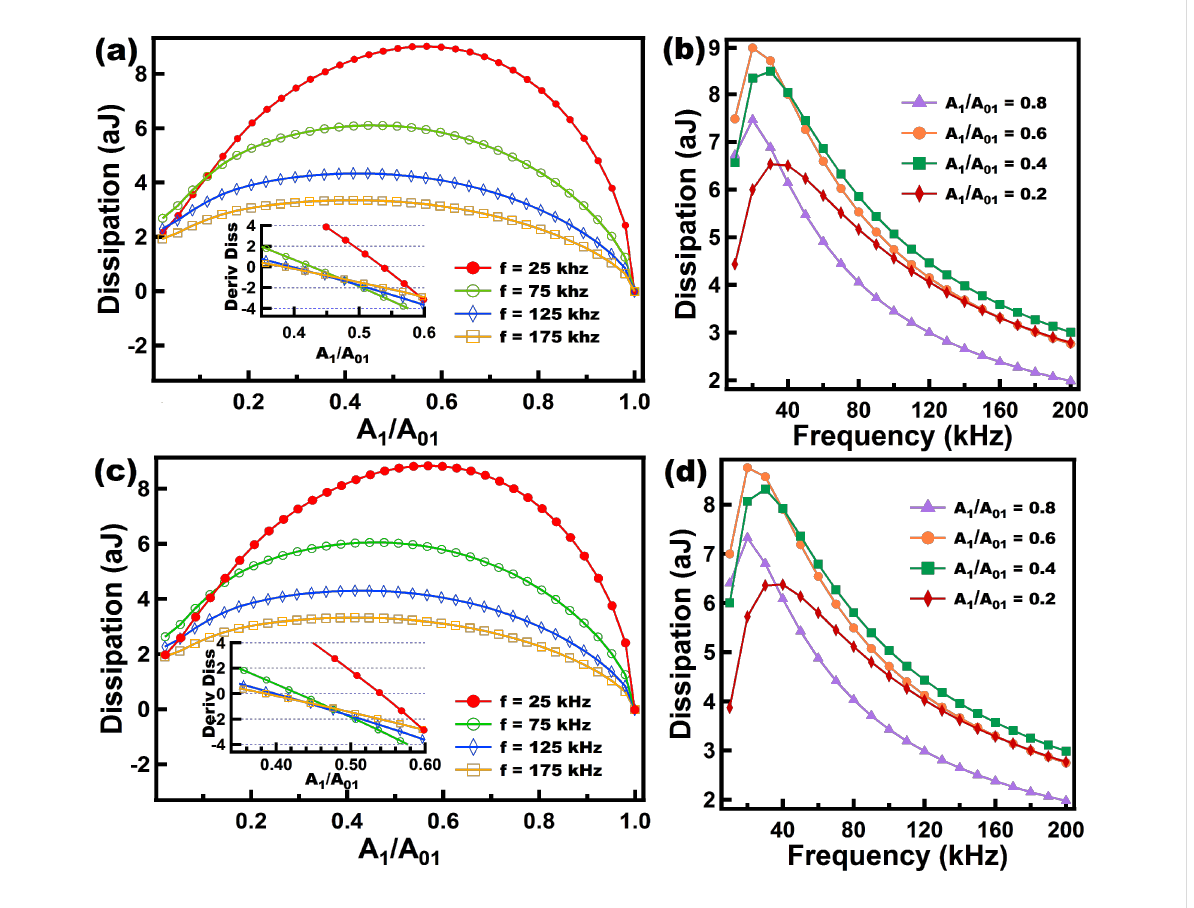
Figure 9: (a) and (c) show dissipation vs amplitude setpoint ( A 1 / A 01 ) curves where each color coded line corresponds to a specific eigenfrequency, for the Wiechert and the SLS models, respectively. The insets in (a) and (c) show the slope of the curves in (a) and (c) plotted over a range near where the slopes cross the x -axis, in order to easily locate the maxima of the curves in (a) and (c). (b) and (d) show the behavior of dissipation as frequency increases, and each color coded line relates to a specific amplitude setpoint ( A 1 / A 01 ) for the Wiechert and the SLS models, respectively. The parameters for the cantilever dynamics were the same as in Figures 6 to 8. The sample parameters for (a) and (b) were: k e = 10 N/m, k 1 = 7.5 N/m, k 2 = 7.5 N/m, c 1 = 0.5 × 10 − 5 N·s/m, and c 2 = 100.0 × 10 − 5 N·s/m. The sample parameters for (c) and (d) were: k e = 17.5 N/m, k = 7.5 N/m, c = 0.5 × 10 − 5